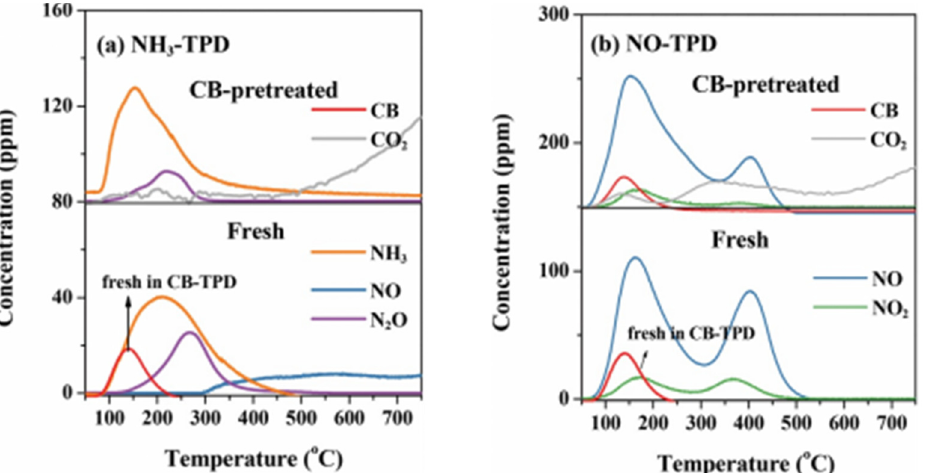
Figure 3. The NH 3 -TPD ( a ) and NO-TPD (b) profiles of the fresh and CB pre-treated catalysts. Reaction conditions: NO, 500 ppm (when used); CB, 50 ppm (when used); NH 3 , 500 ppm (when used); N 2 as the balance gas [88]. Copyright The Royal Society of Chemistry 2019.